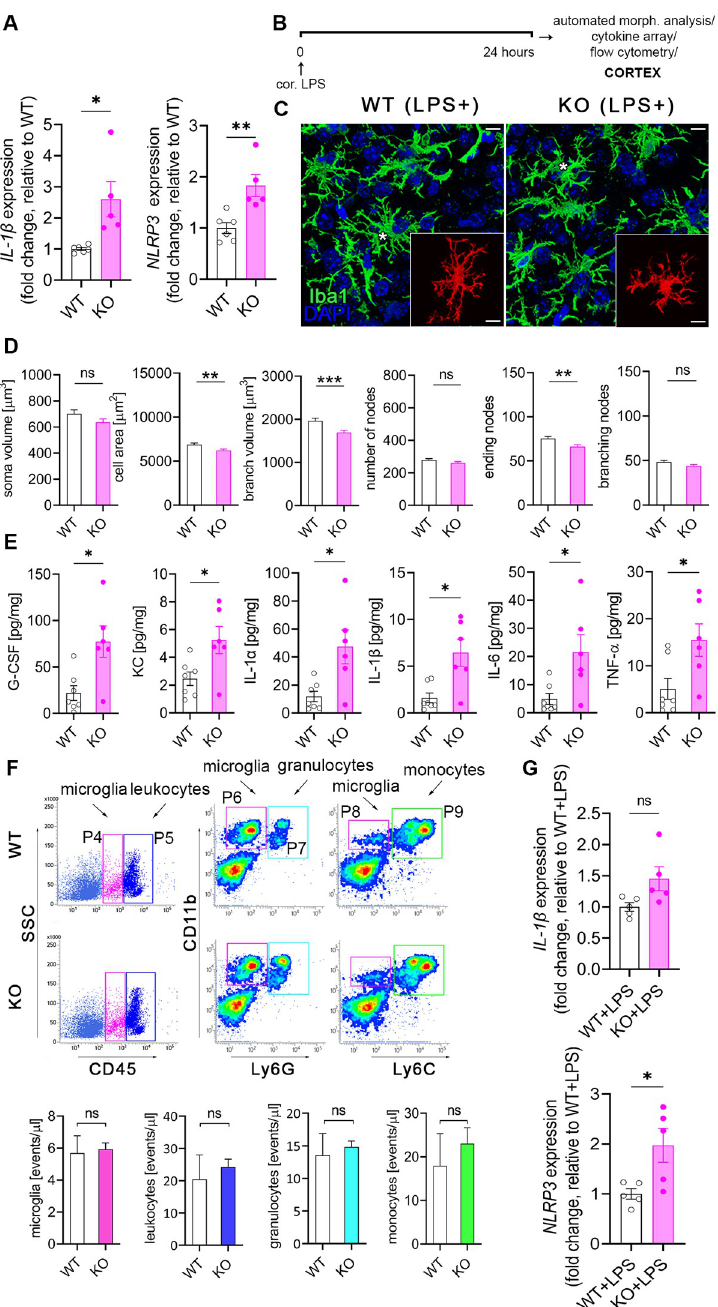
Fig 4. The absence of microglial NKCC1 boosts inflammatory cytokine production in the cerebral cortex in response to an inflammatory stimulus. (A) Baseline NLRP3 and IL-1 β mRNA expression is increased in isolated NKCC1 KO microglia compared to WT cells. ( B) Experimental outline of automated morphological analysis, cytokine array, and flow cytometry. (C, D) Automated morphological analysis shows that activated NKCC1-deficient microglia are slightly smaller than their WT counterparts. (E) LPS-induced cytokine levels are significantly higher in the cortices of microglial NKCC1 KO mice than in WT. ( F) Flow cytometric dot plots show that microglial NKCC1 deficiency does not alter the number of CD11b + , CD45 int microglia (P4 gate) or numbers of infiltrating CD11b + , CD45 high leukocytes (P5 gate), CD11b + , Ly6C high monocytes (P9 gate) and CD11b + , Ly6G high granulocytes (P7 gate) in response to intracortical LPS administration. See corresponding data on peripheral cytokine levels and immune cell populations in S3 Fig . (G) Increased NLRP3 and IL-1 β mRNA levels are sustained in NKCC1 KO and WT microglia 24 hours after intracisternal LPS administration . (A) Unpaired t test; � p < 0.05, �� p < 0.01; N (WT) = 6, N (KO) = 5. ( C) Scale: